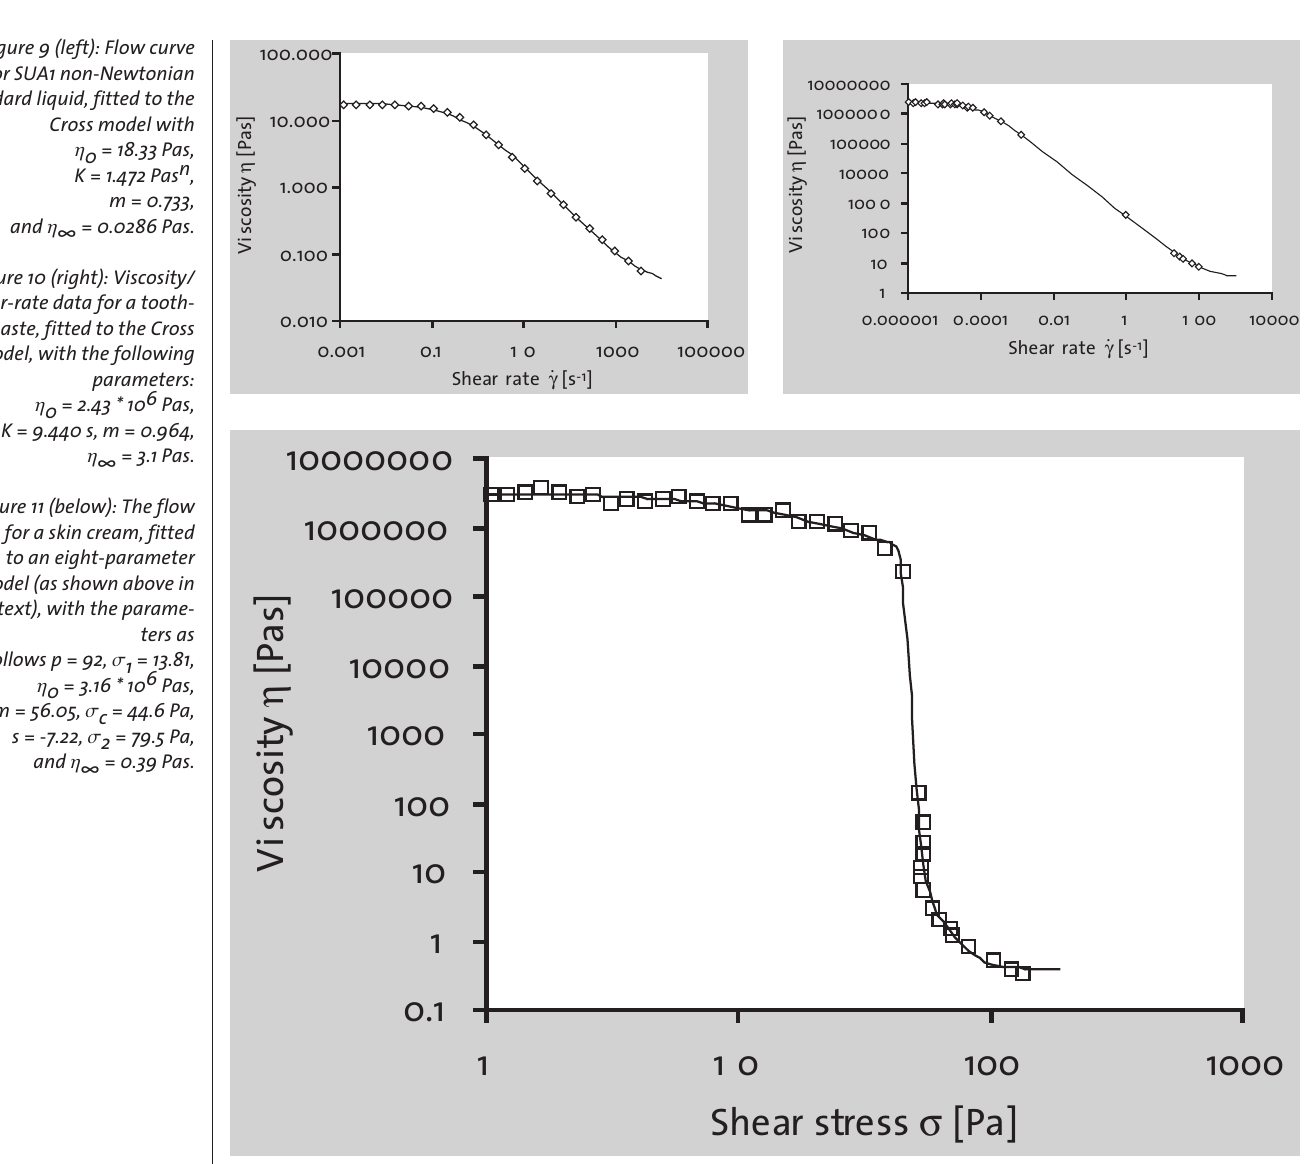
and h ∞ = 0.0286 Pas. Figure 10 (right): Viscosity/ shear-rate data for a tooth- paste, fitted to the Cross model, with the following